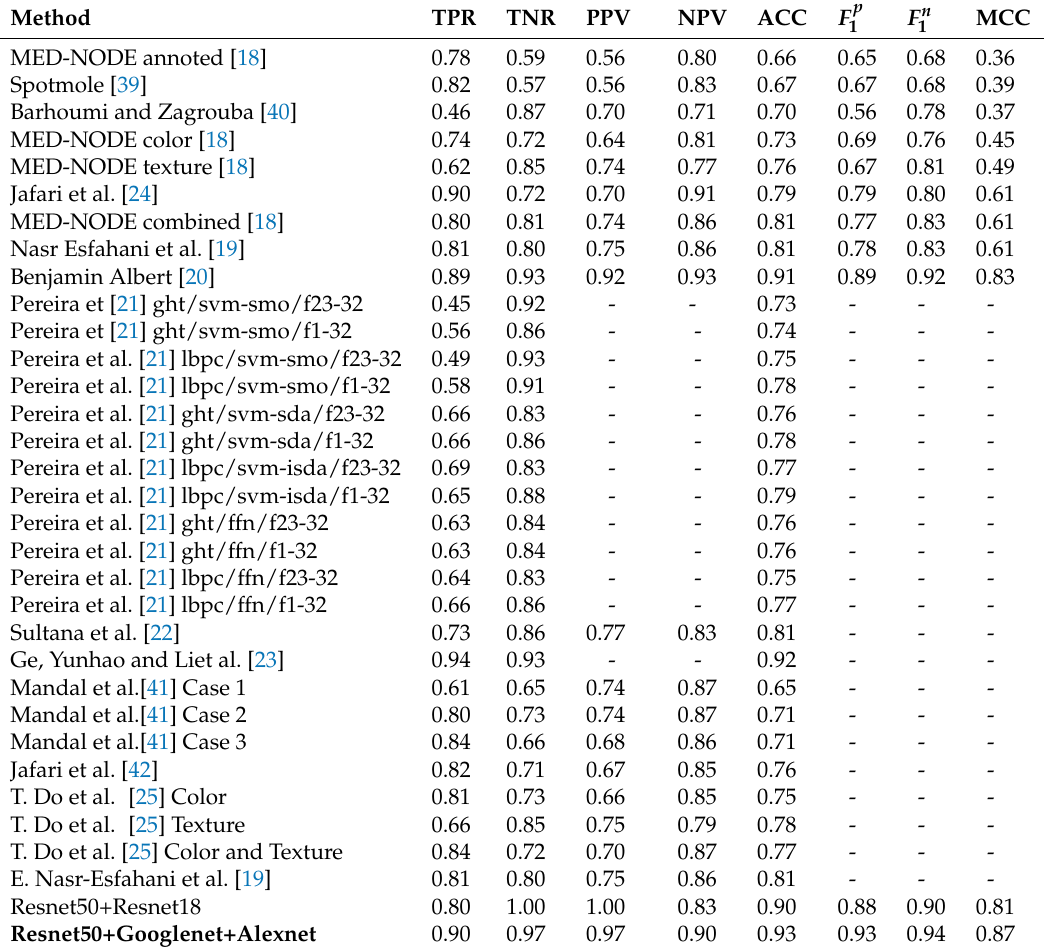
Table 4. Experimental results on the MED-NODE